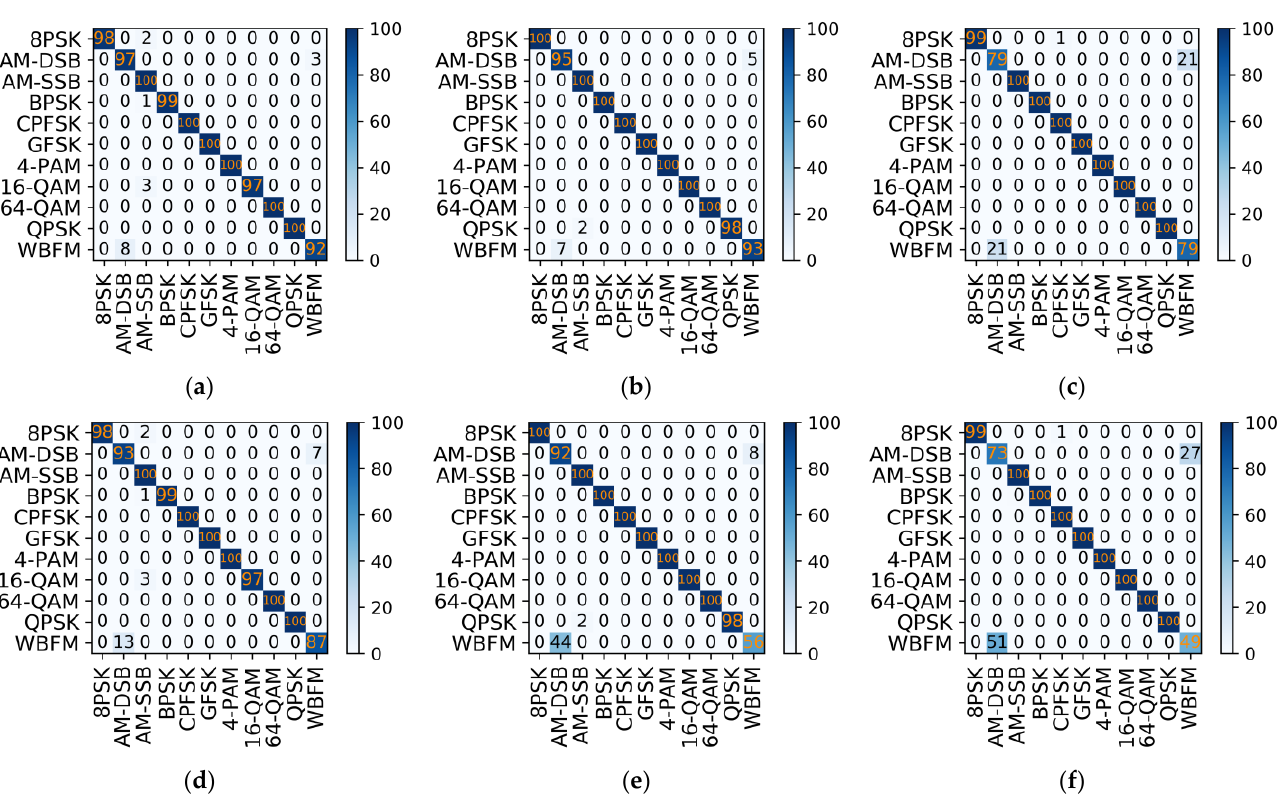
Figure 13. Partial confusion matrices on the RML2016.10b dataset about two networks. ( a ) IQGMCL-